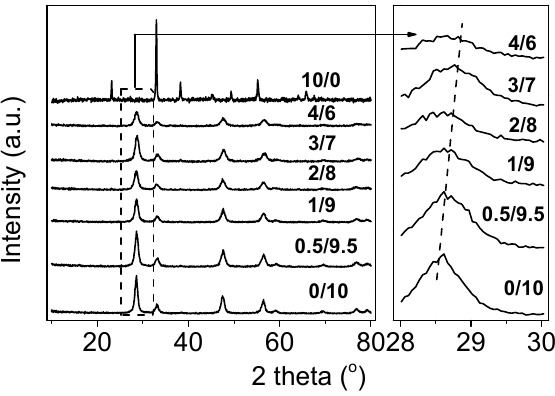
Figure 1. XRD patterns of Ce 1 − x Mn x O 2 − δ -supported Au catalysts with different Mn/Ce ratios.